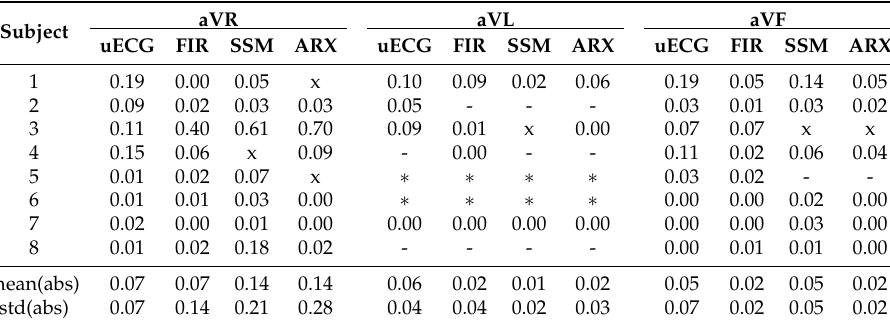
Table A2. Mean squared error for the amplitude deviation of the Q